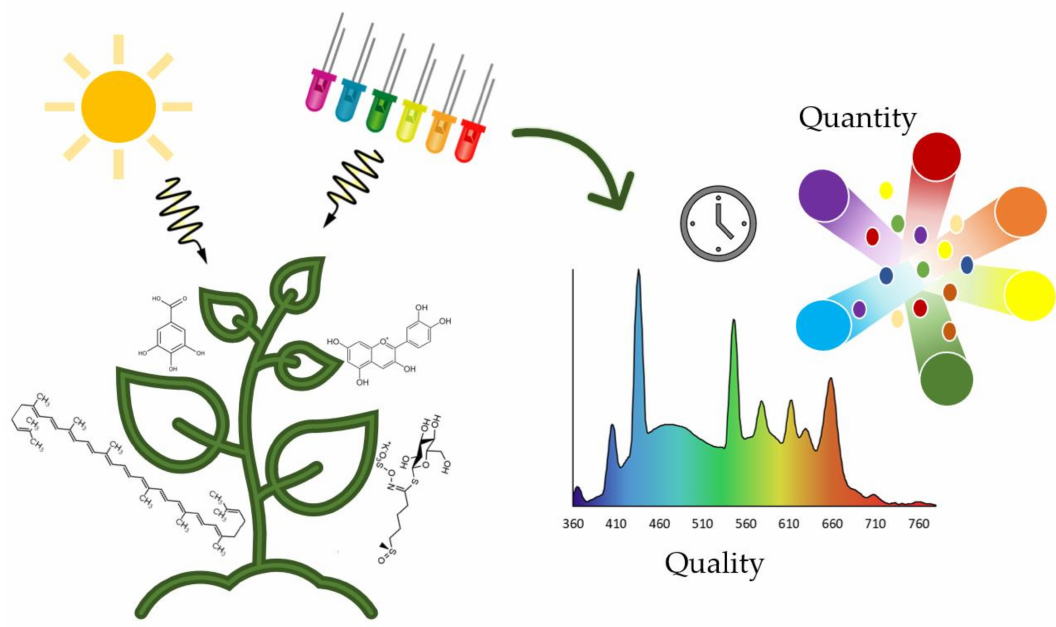
Figure 2. Key light factors influencing the plant secondary metabolism to produce bioactive